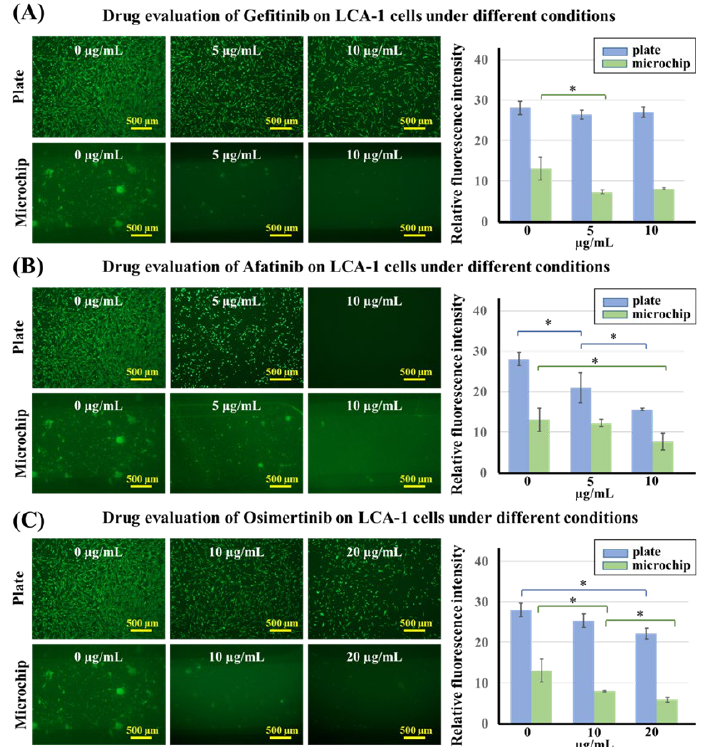
Figure 5. ( A ) Drug evaluation of EGFR-targeted drugs with different concentrations of gefitinib on LCA-1 cells using the 2D well plate and 3D lung-on-a-chip methods. ( B ) Drug evaluation of EGFR-targeted drugs with different concentrations of afatinib on LCA-1 cells using the 2D well plate and 3D lung-on-a-chip methods. ( C ) Drug evaluation of EGFR-targeted drugs with different concentrations of osimertinib on LCA-1 cells using the 2D well plate and 3D lung-on-a-chip methods. n = 3, * p <